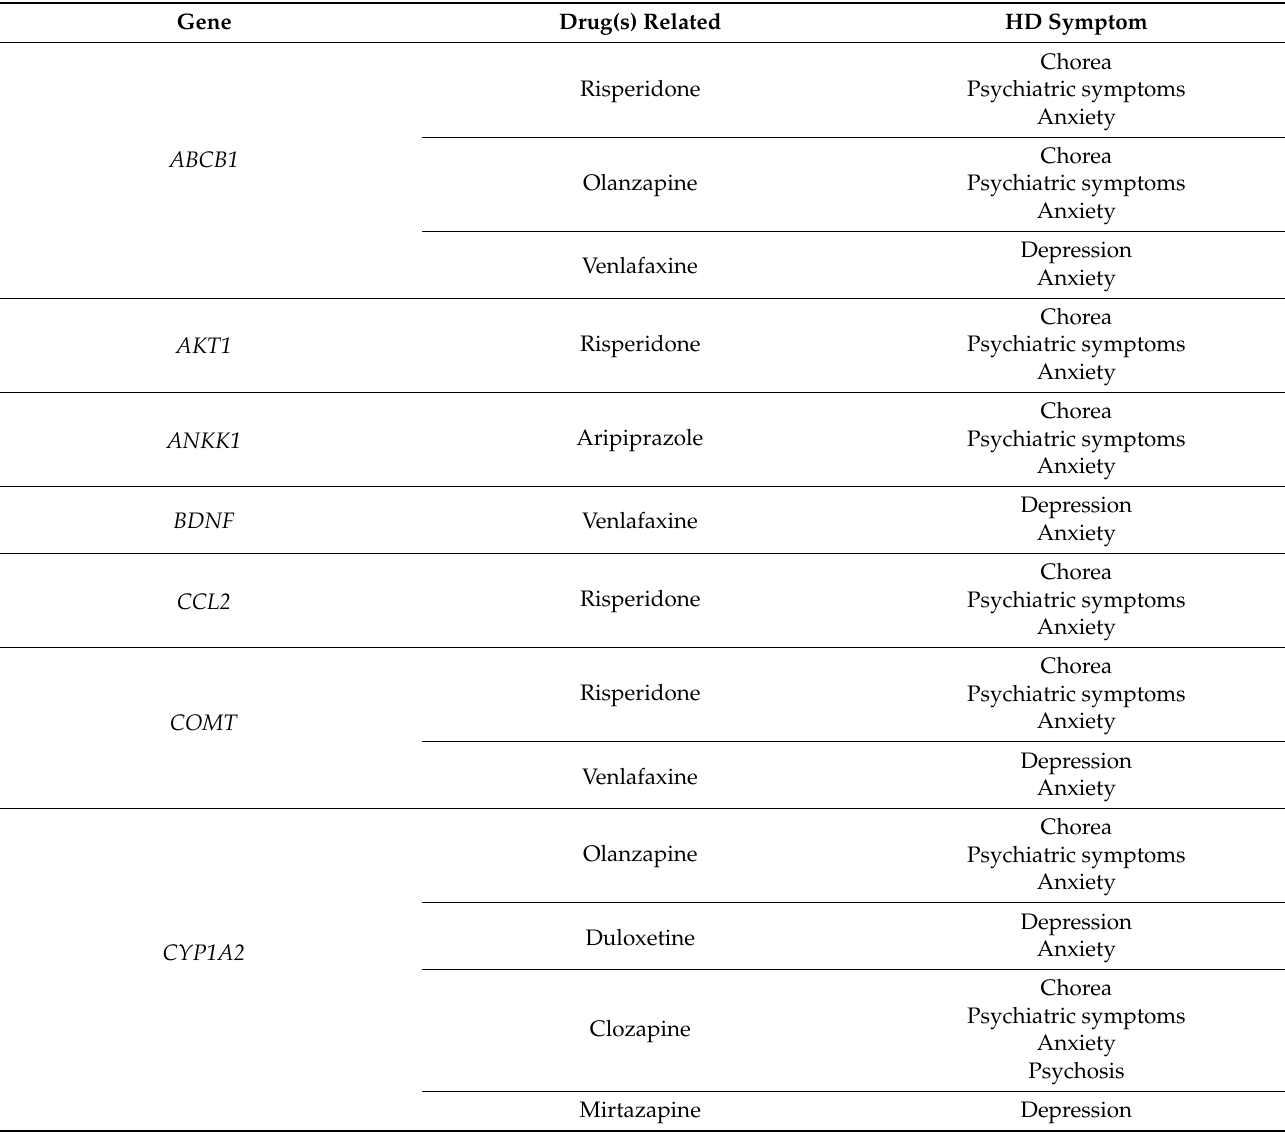
Table 2. An overview of the relevant gene variations for the drugs addressed in this review.